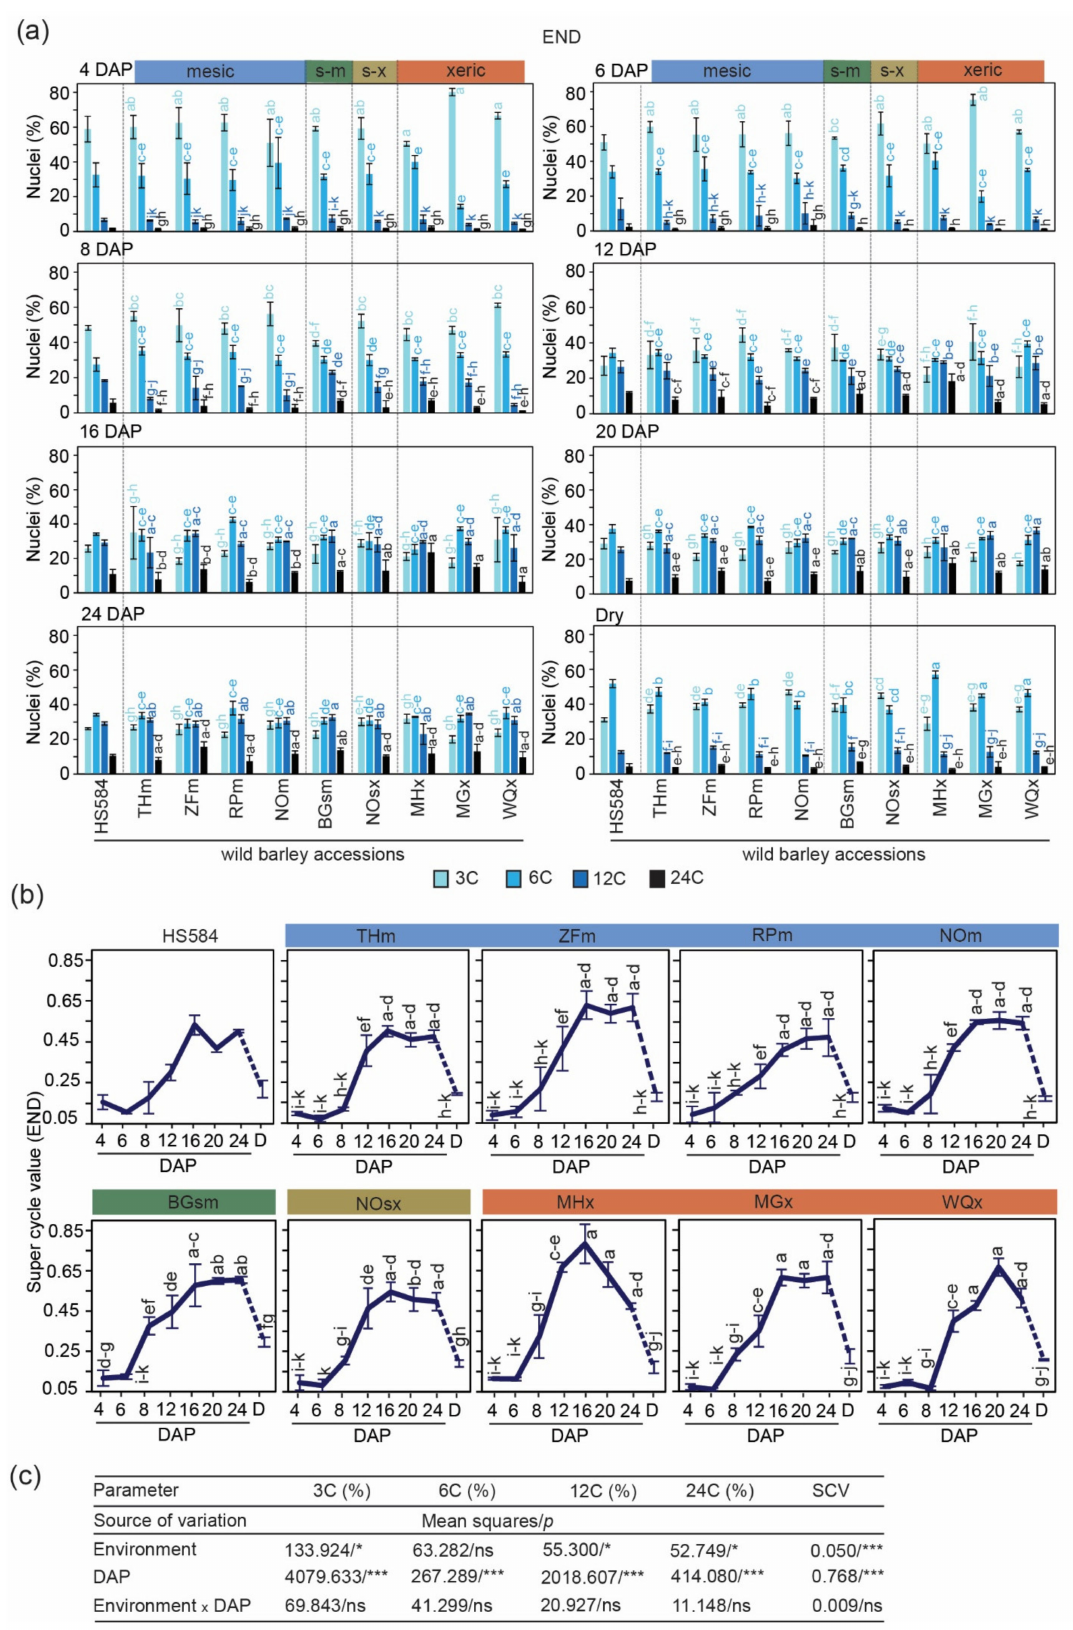
Figure 4. Estimation of C-values in triploid endosperm (END) tissues of ten analyzed wild barley accessions. ( a ) Percentage of 3C, 6C, 12C and 32C nuclei at a given day after pollination (DAP) and in dry seeds. Mesic accessions: THm = Tel